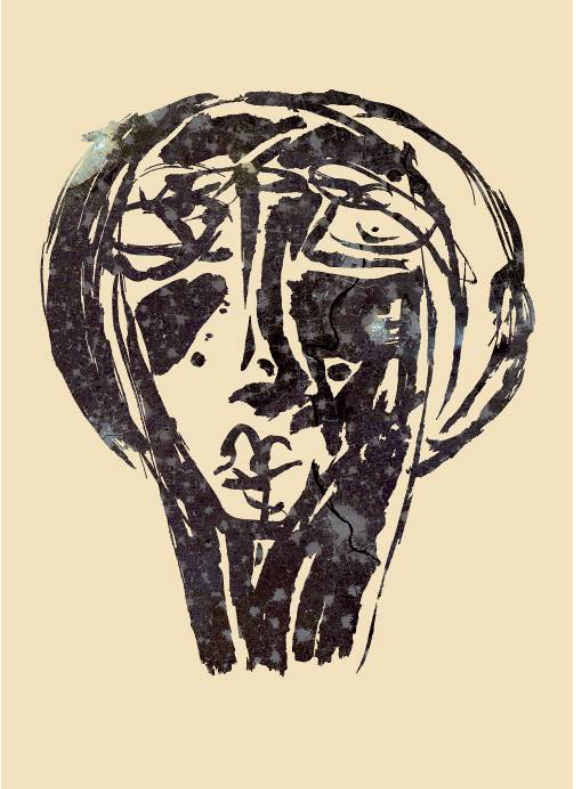
Figure 3 Tamer Assem – Cairo Man – Digital Print – 70x50cm – (2017)